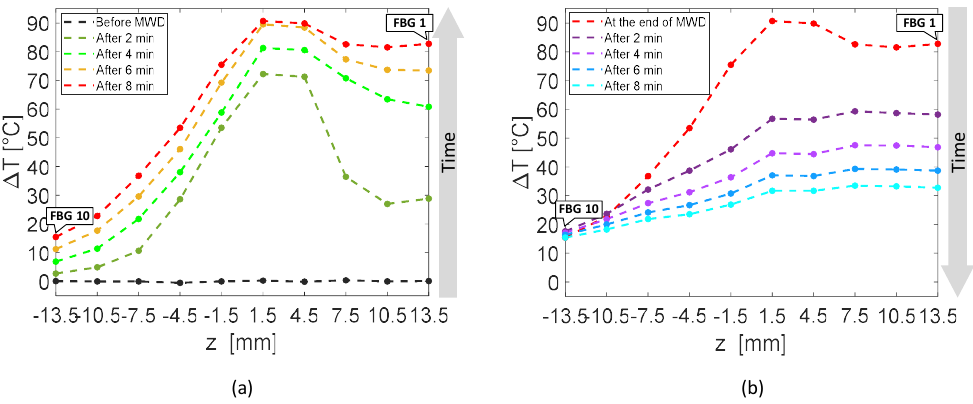
Figure 6. Temperature variations recorded by the ten FBGs of array A 4 versus distance, along the axis of the array, parallel to the z -axis: ( a ) rising temperature profiles recorded every 2 min, starting before the antenna activation to the end of the MW discharge (MWD), which happened 8 min later; ( b ) decreasing temperature profiles starting from the antenna shutdown and recorded 2 min, 4 min, 6 min and 8 min later.